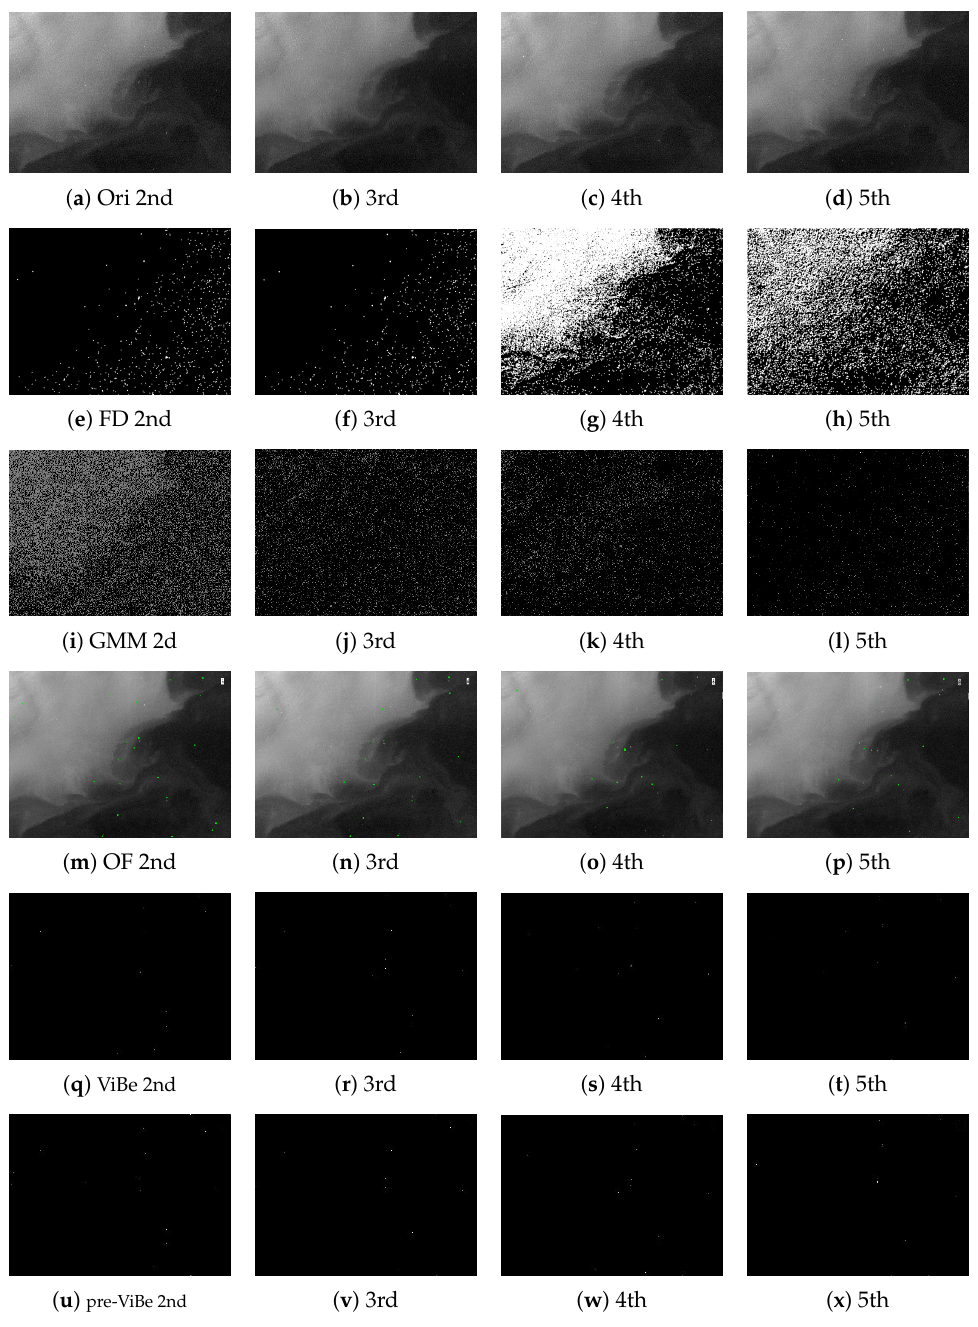
Figure 9. From top to bottom are the original image, the results of frame difference (FD), Gaussian mixture model (GMM), optical flow (OF), Visual Background Extractor (ViBe), and preprocessing + ViBe (pre-ViBe); from left to right are the second frame to the fifth frame of the image sequence (one frame per 3